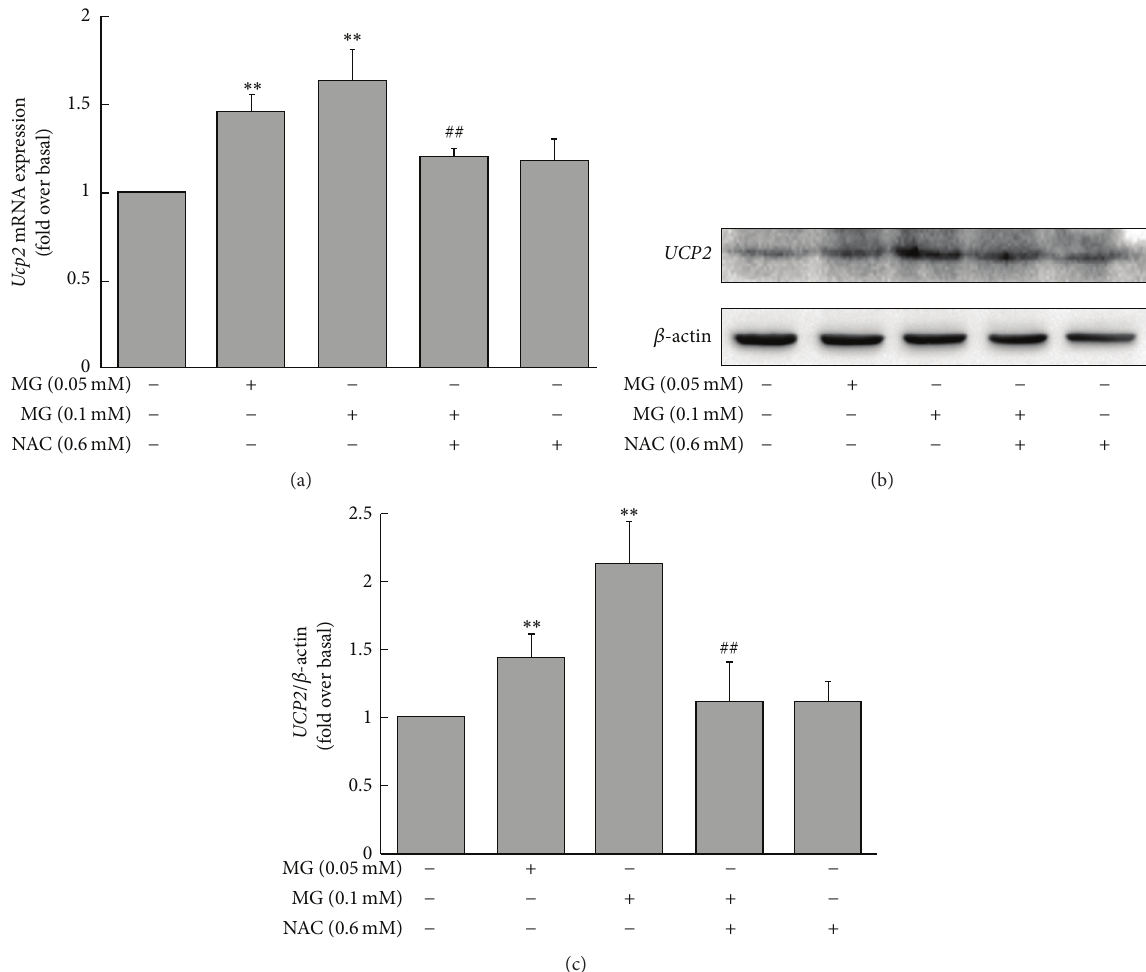
Figure 5: Effects of MG on Ucp2 mRNA and UCP2 protein levels in MIN6 cells. The expression of Ucp2 mRNA (a) and UCP2 protein ((b) and (c)) was increased by treatment with MG. Cells were incubated with 0.05 or 0.1 mM MG for 3 h. Results are fold change compared to baseline (0mM MG + 0 mM NAC). The effects of MG were reversed by coincubation with NAC. ∗∗ 𝑝 < 0.01 compared to control group (0mM MG + 0 mM NAC). # 𝑝 < 0.05 , ## 𝑝 < 0.01 compared to the higher MG group (0.1mM MG + 0mM